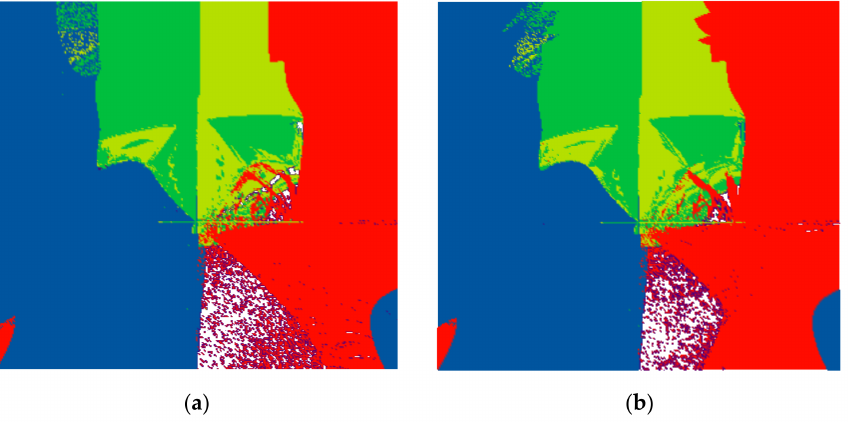
Figure 11. “Portrait” of the system roots (2), obtained by the Conjugate Gradient ( a ) and Quasi- Newton ( b ) method.